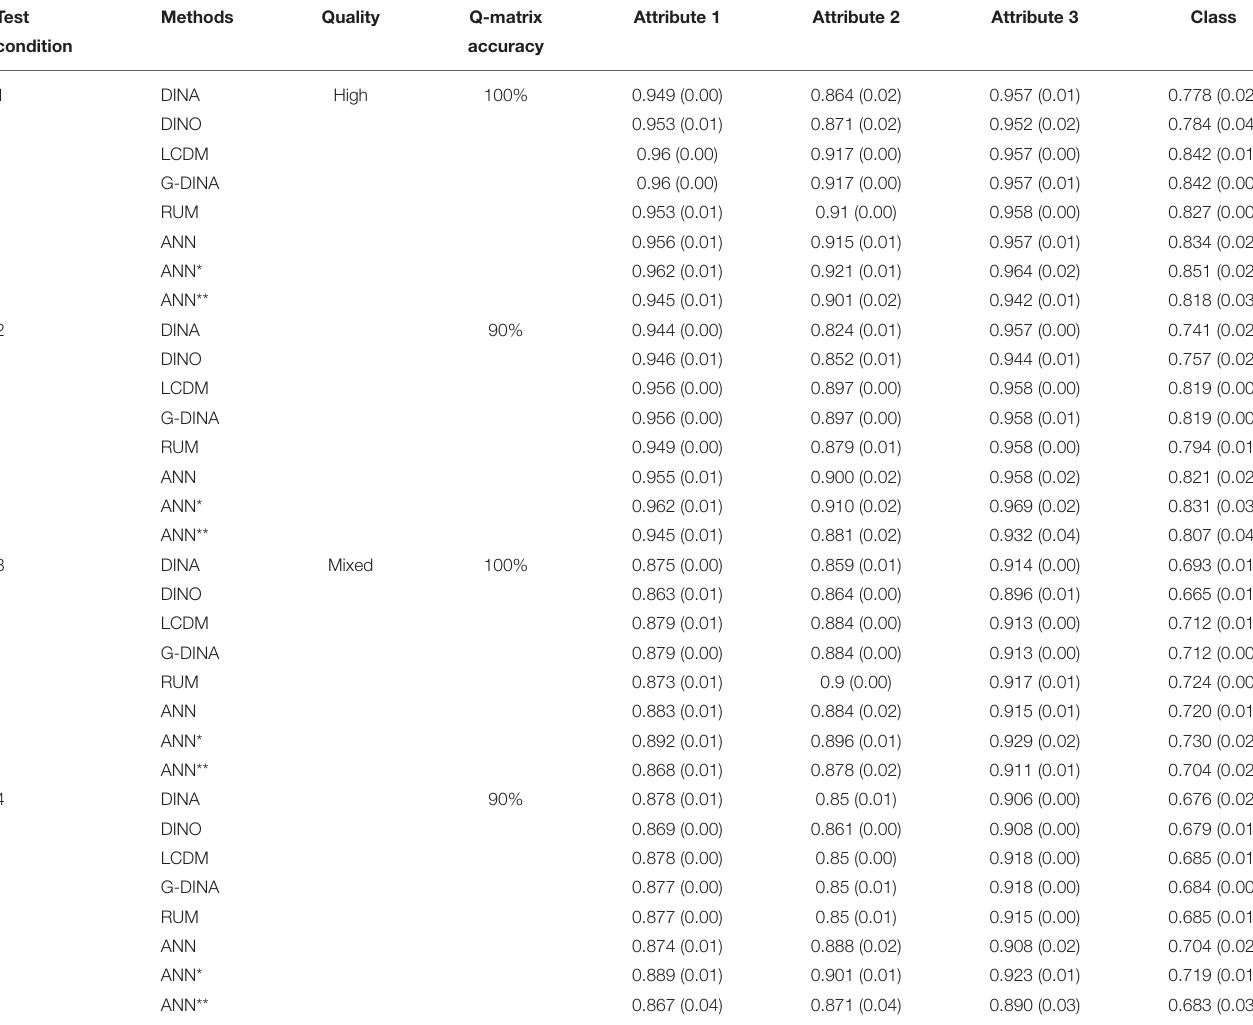
TABLE 2 | Comparison of classification rates for three attributes using 20